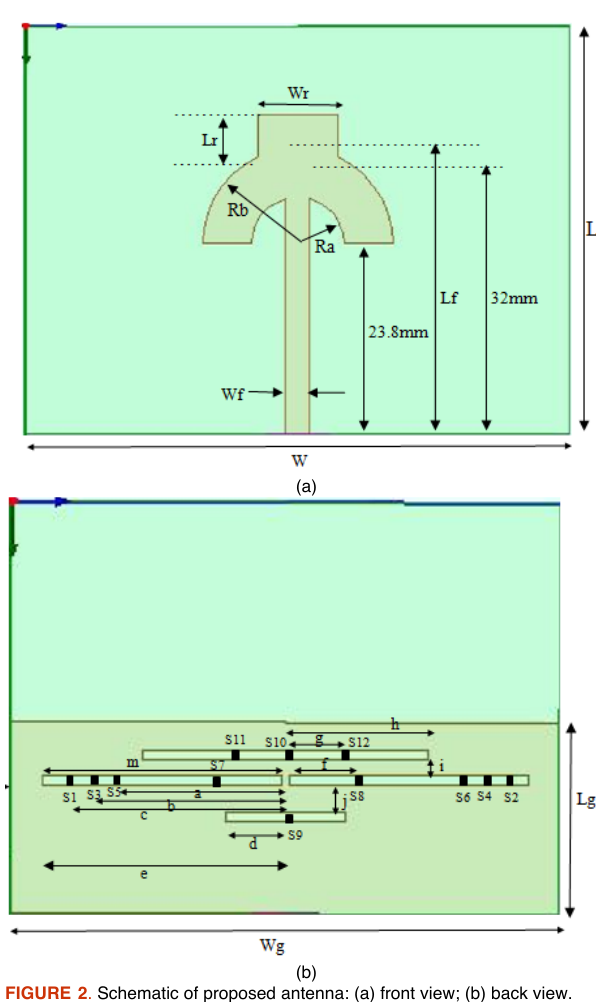
(b) FIGURE 2 . Schematic of proposed antenna: (a) front view; (b) back view. For the OFF state (reverse biased), the circuit has a parallel combination of resistance and capacitance with Rp = 5 kΩ and Cp = 0.15 pF, and for the ON state (forward biased), only the resistance Rs =3 Ω is considered for simulation of the